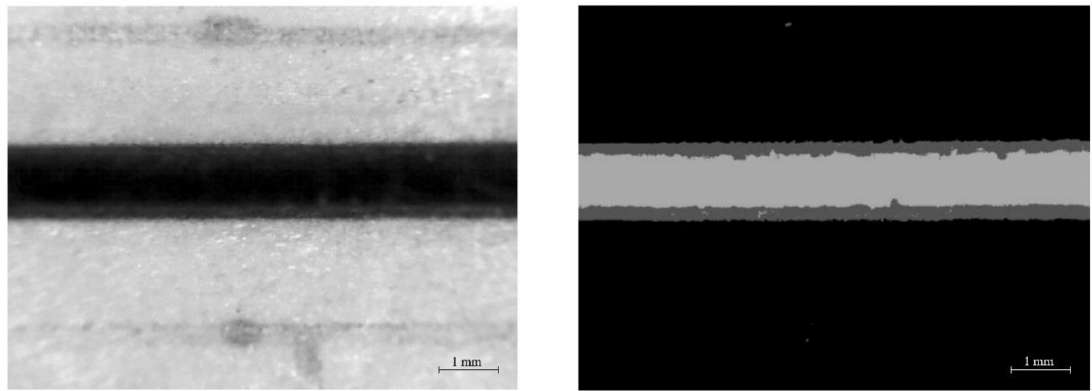
Figure 2. Photo used for measuring the width of the cutting kerf and heat-a ff ected zone ( left ), and photo edited by segmentation ( right ) by Digital Microscopy